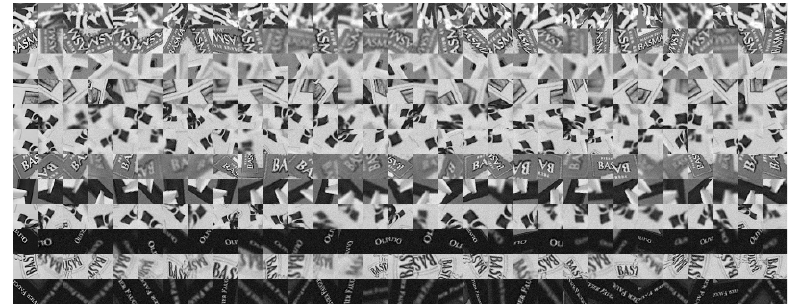
Figure 5. Image patch samples generated randomly for training and testing processes. Each row contains several possible appearances of a keypoint neighborhood.